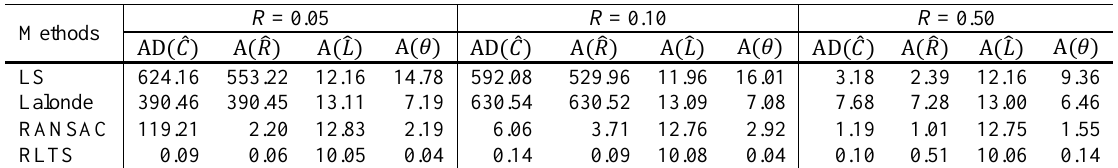
Table 3. Evaluation of estimated parameters for cylinders with different radii (in metre) [ AD(𝐶̂) = Average Distance between the real cylinder centres and the fitted cylinder centres, A(𝑅̂) = estimated Average radius, A(𝐿̂) = estimated Average length, and 𝐴(𝜃) = Average bias